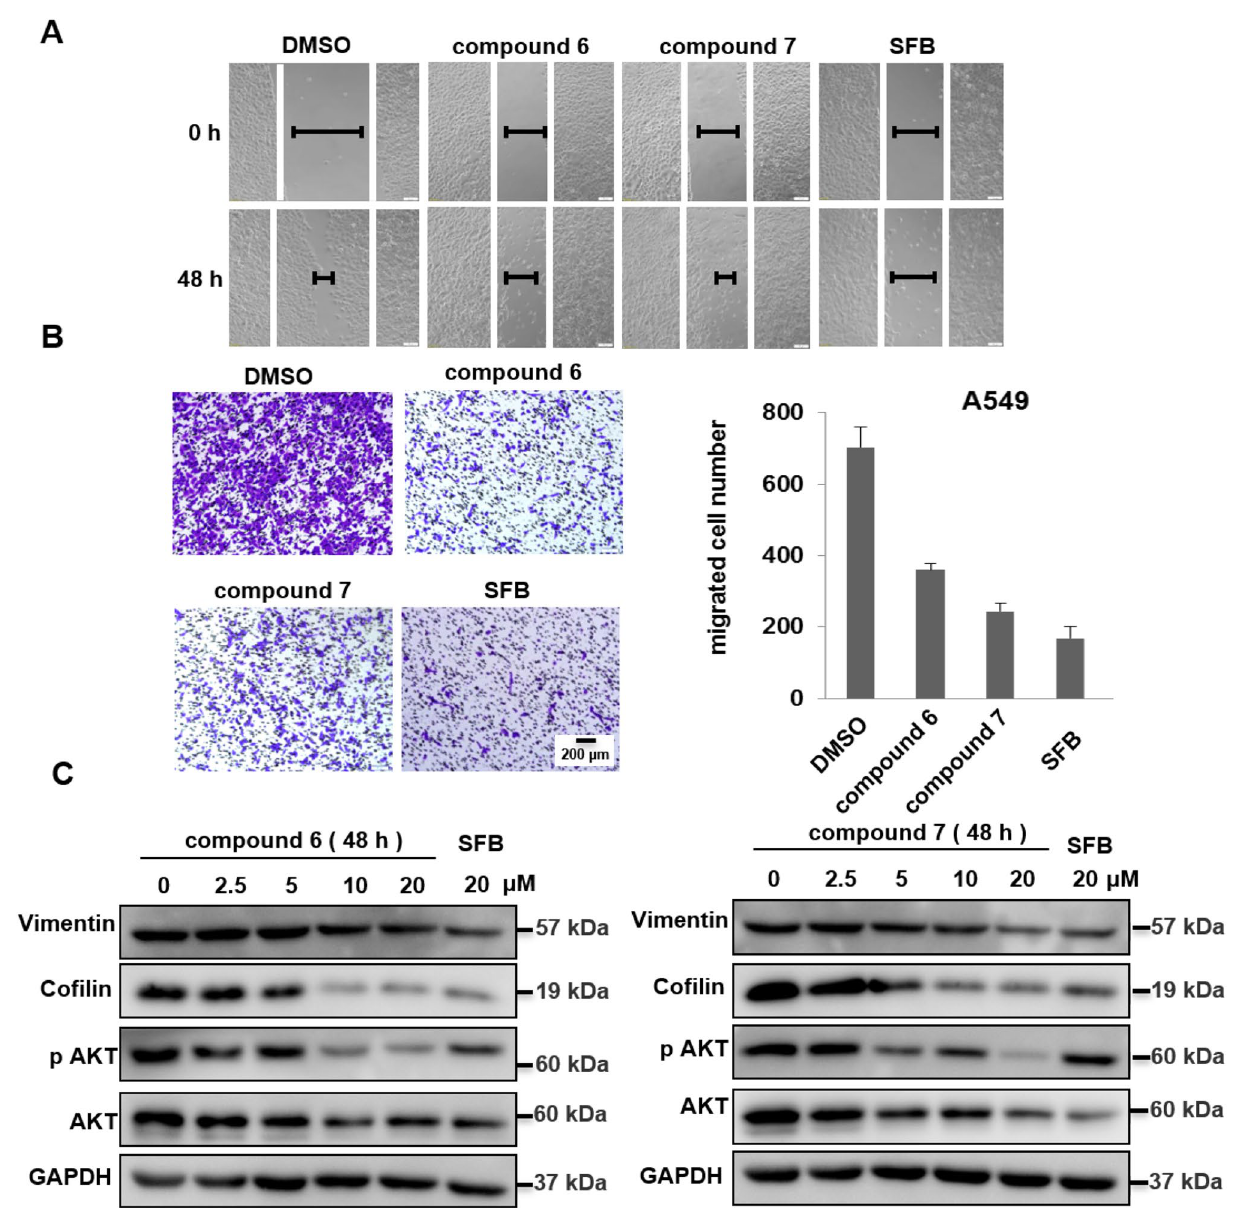
Fig. 8 a Wound healing assay. A549 cells were treated with com- pounds 6 and 7 and positive control Sorafenib (20 μ M) and monitored with an inverted microscope. b Cell migration was measured by tran- swell assays. The summary data for transwell migration assay was